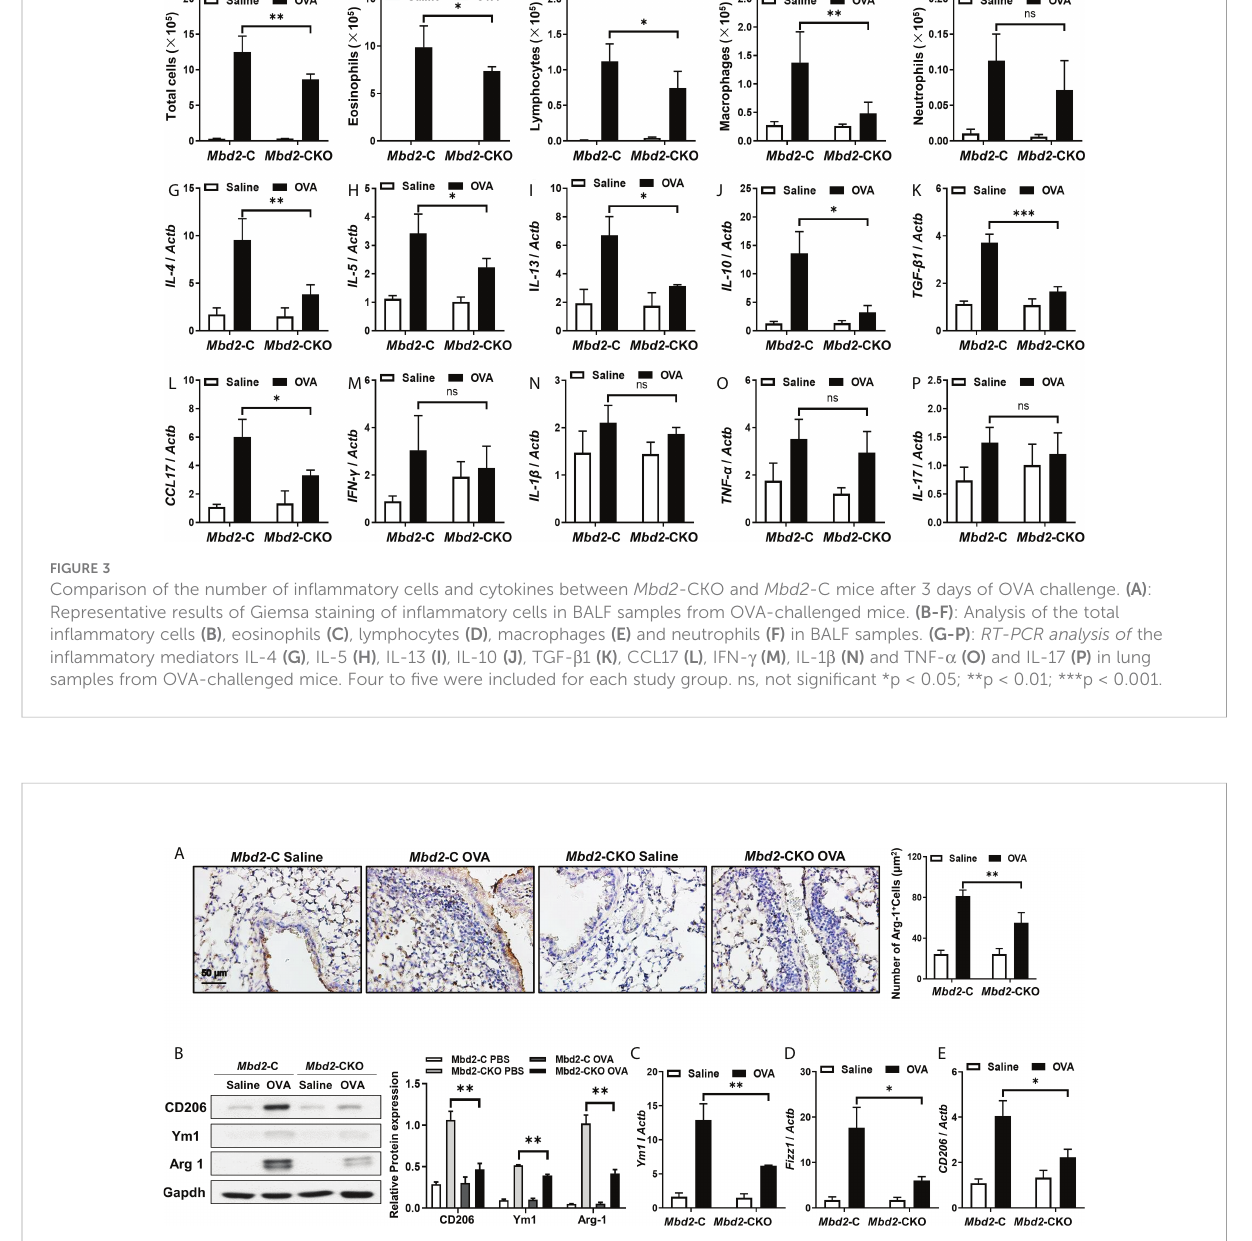
FIGURE 4 Mbd2 promoted the M2 macrophage program in mice following 3 days of OVA challenge. (A) : Representative results of IHC for Arg-1 in lung sections from Mbd2 -C and Mbd2 -CKO mice. (B) : Western blot analysis of Arg-1 expression in lung homogenates. Left panel: Representative Western blot results. Right panel: Bar graph showing the expression levels of Arg1 in all mice of each group examined. (C – E) : RT-PCR results for the analysis of Ym1 (C) , Fizz1 (D) and CD206 (E) expression in the lung. The data were collected from studies of 4-5 mice in each study group. *p < 0.05; **p <